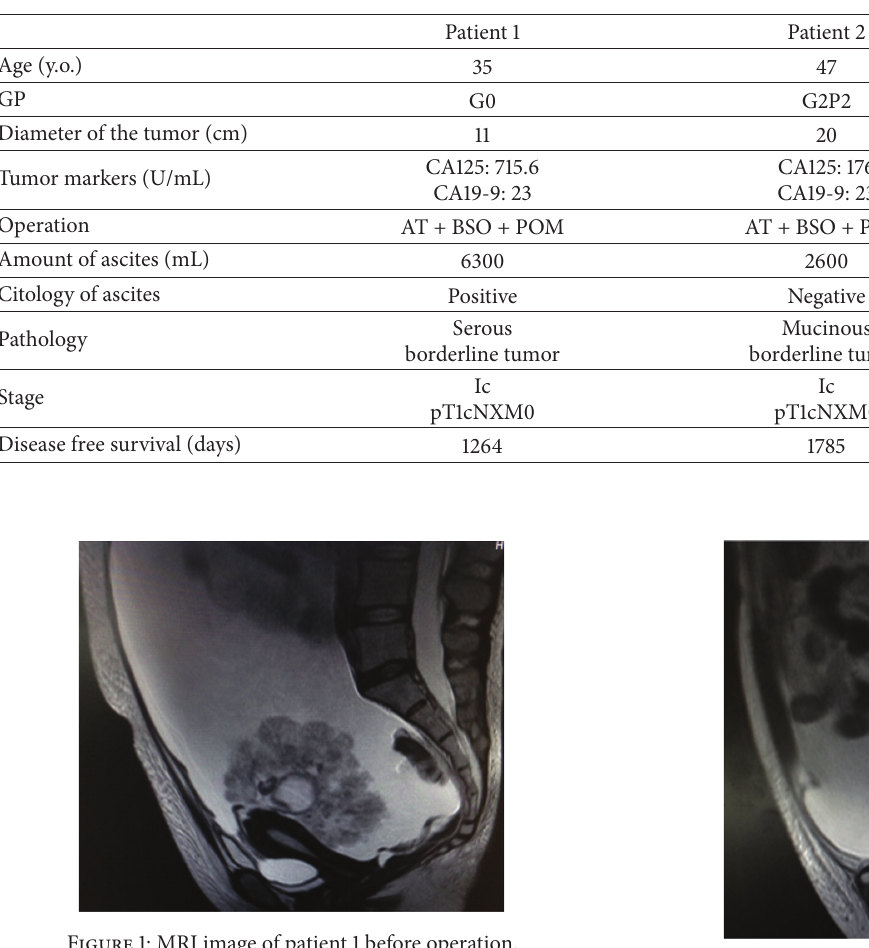
Table 1: The list of the patients.